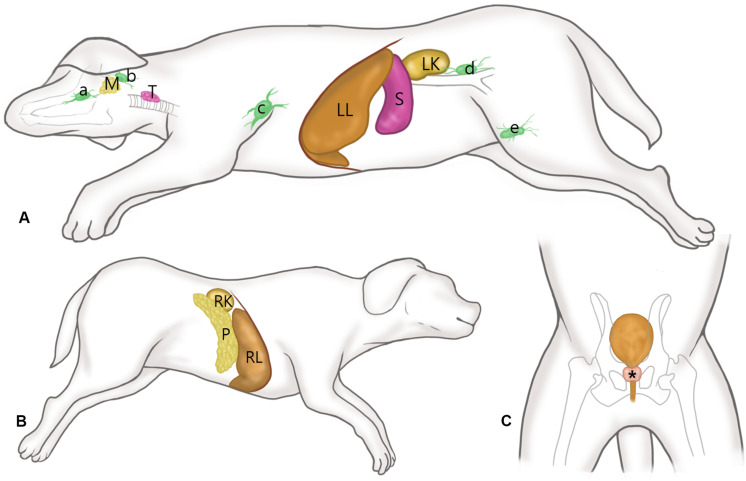
Schematic representations of the canine anatomy with indication of the examined soft tissue organs. (A) After placing the dogs in right lateral recumbency, shear wave elastography (SWE) of the submandibular (a), retropharyngeal (b), axillary (c), inguinal (d) and medial iliac (e) lymph nodes, submandibular salivary gland (M), thyroid (T), spleen (S), left liver lobe (LL), and left kidney (LK) was performed in the left side for each dog, while maintaining the vertical angle of the probe to the organ. (B) With the dog positioned in left lateral recumbency, SWE of the pancreas (P), right liver lobe (RL), and right kidney (RK) were performed. (C) SWE in the prostate (*) was conducted in the right and left lobes in the transverse images with the dog in dorsal recumbency.